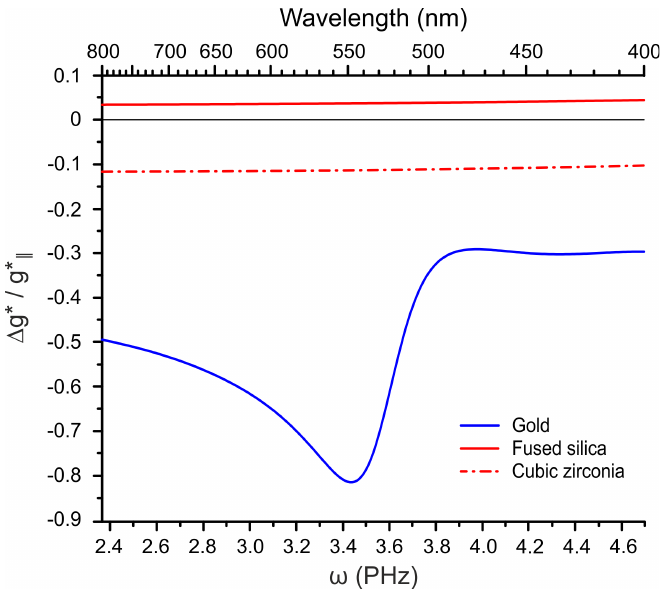
Figure 4. Frequency dependence of the reduced anisotropy of the effective gyration tensor ∆ g ∗ / g ∗ (cid:107) of the gold, fused silica and cubic zirconia NPs dressed with chiral organic molecules in the nematic host 5CB.